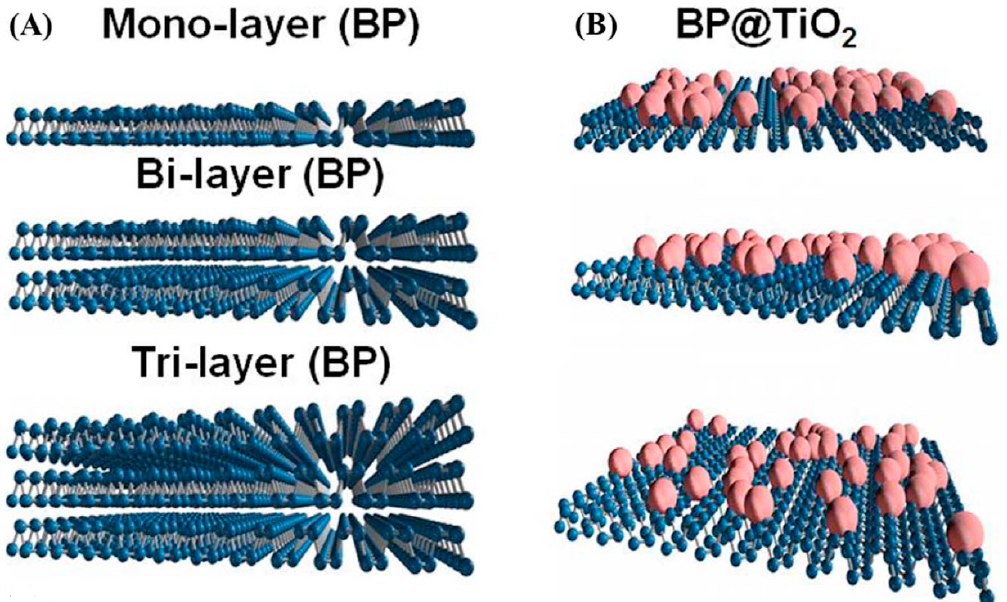
Figure 10. TiO 2 substitution on BP [127]. (Reprinted with permission from Lee, H.U., et al., Sci. Rep., 2015. 5: p. 8691.)